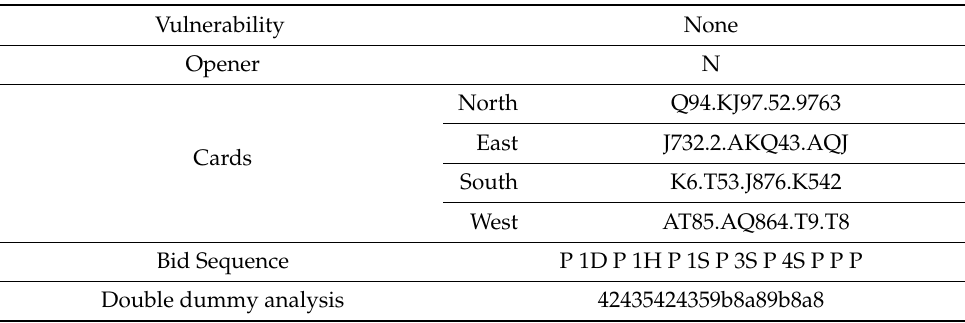
Table 3. An example of training data in